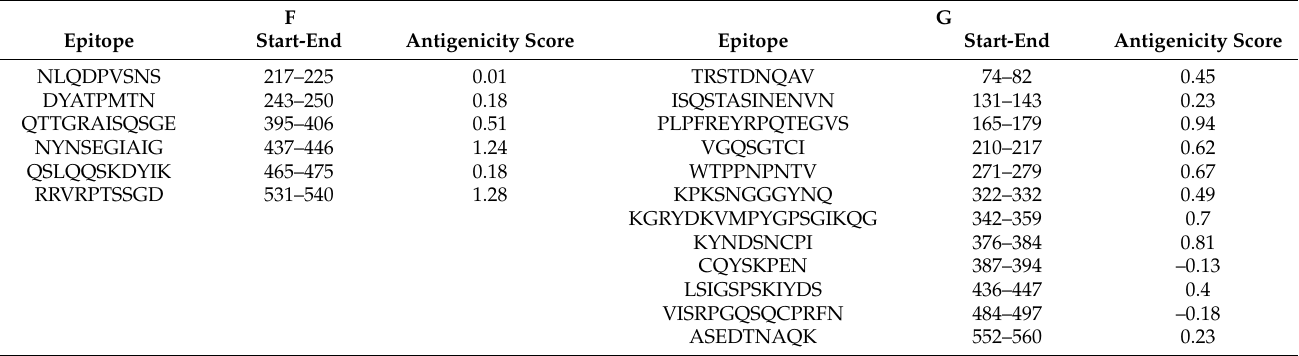
Figure 1. BepiPred linear epitope prediction for F ( A ), G ( B ), and V ( C ) proteins; the yellow section represents the B epitope part of each protein. Table 1. Predicted B cell epitopes from F and G proteins.